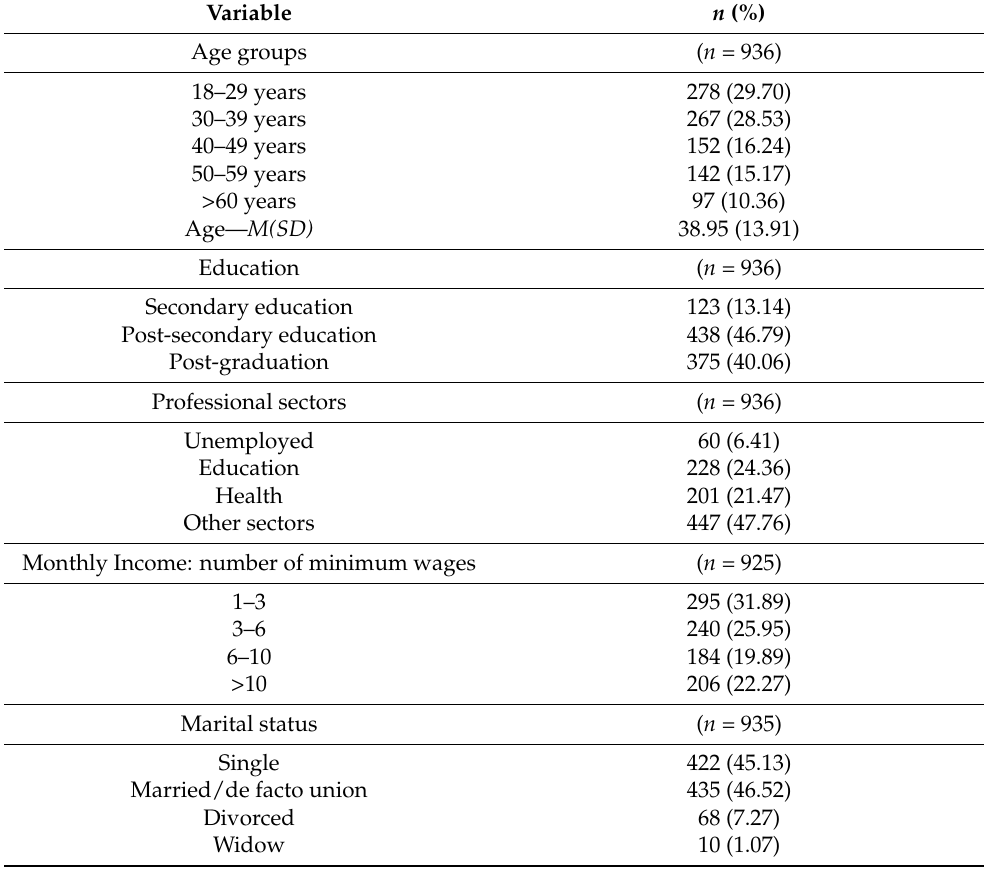
Table 1. Demographic characteristics of the